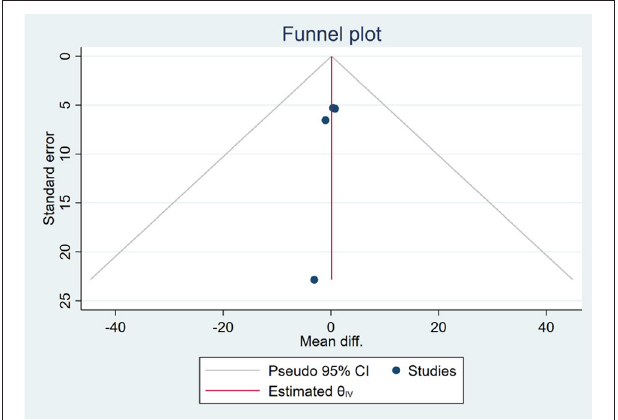
FIGURE 26 | Funnel plots of the effect of TG.